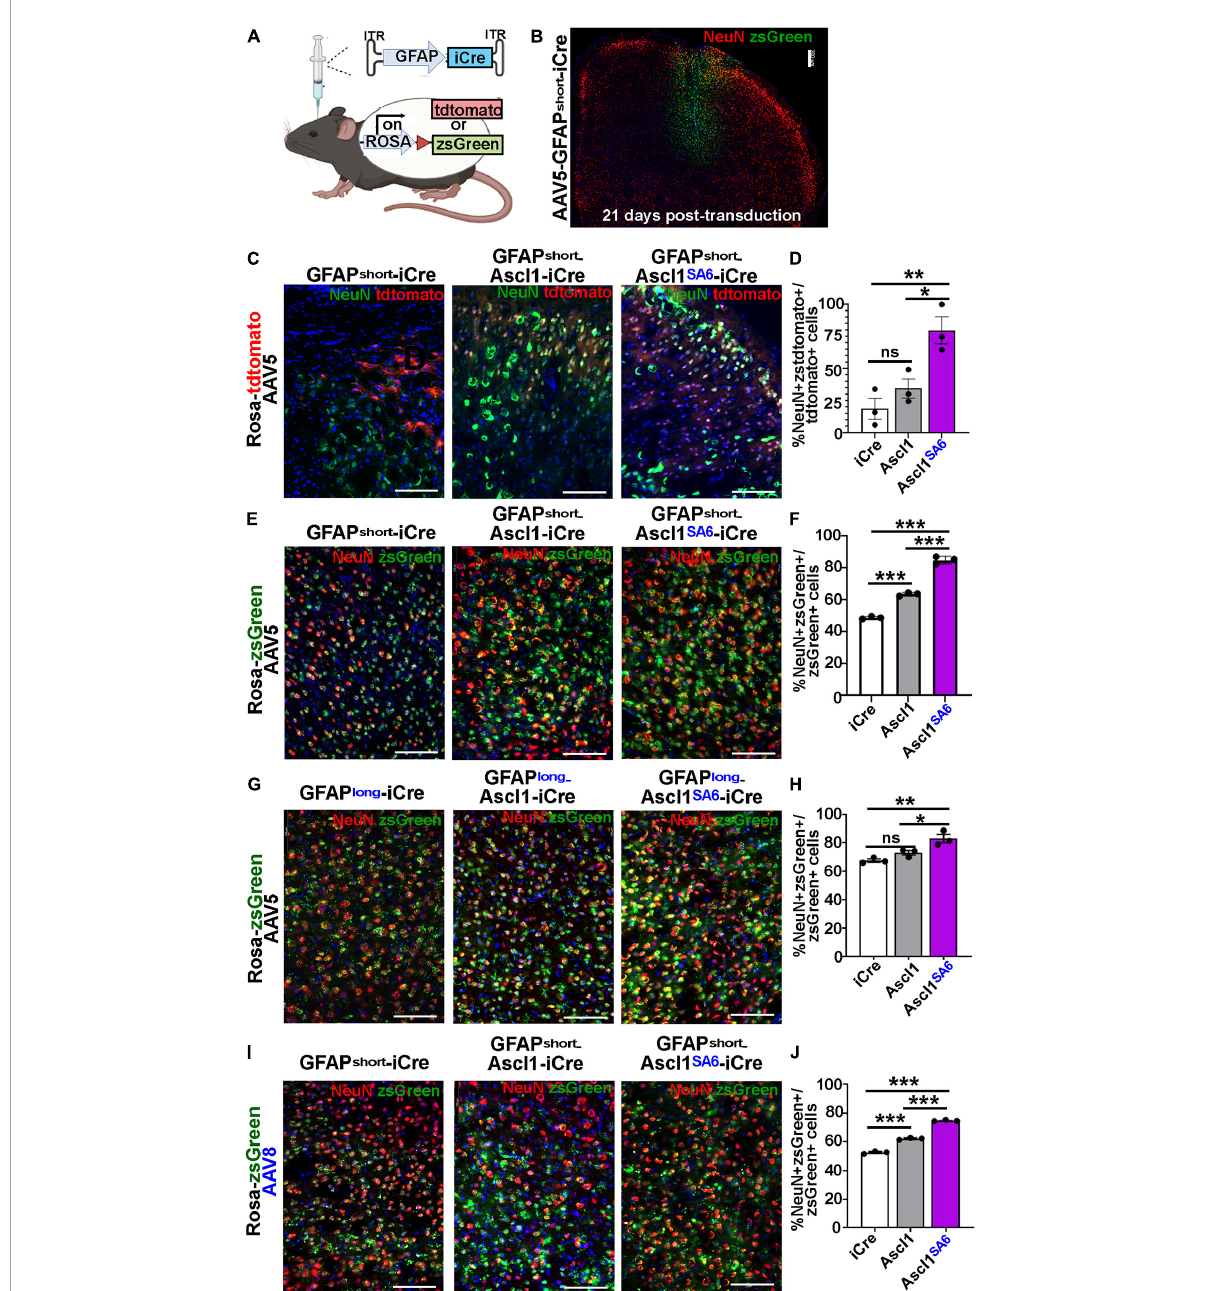
FIGURE4 Ascl1 SA 6 induces more transduced cortical cells to express NeuN, a mature neuronal marker, than Ascl1. (A) Schematic illustration of Cre-based lineage tracing strategy, using AAV5-GFAPshort vectors and Rosa-tdtomato or Rosa-zsGreen transgenic animals. (B) Low magnification image of Rosa-zsGreen cortex transduced with AAV5-GFAPshort-iCre at 21 days post-transduction, showing zsGreen epifluorescence and NeuN expression. (C) Rosa-tdtomato cortex transduced with AAV5-GFAPshort-iCre, AAV5-GFAPshort-Ascl1-t2a-iCre, and AAV5-GFAPshort-Ascl1 SA 6 -t2a-iCre at 21 days post-transduction, showing tdtomato epifluorescence and NeuN expression. (D) Quantification of the percentage of tdtomato + cells that co-express NeuN. (E) Rosa-zsGreen cortex transduced with AAV5-GFAPshort-iCre, AAV5-GFAPshort-Ascl1-t2a-iCre, and AAV5-GFAPshort-Ascl1 SA 6 -t2a-iCre at 21 days post-transduction, showing zsGreen epifluorescence and NeuN expression. (F) Quantification of the percentage of zsGreen + cells that co-express NeuN. (G) Rosa-zsGreen cortex transduced with AAV5-GFAPlong-iCre, AAV5-GFAPlong-Ascl1-t2a-iCre, and AAV5-GFAPlong-Ascl1 SA 6 -t2a-iCre at 21 days post-transduction, showing zsGreen epifluorescence and NeuN expression. (H) Quantification of the percentage of zsGreen + cells that co-express NeuN. (I) Rosa-zsGreen cortex transduced with AAV8-GFAPshort-iCre, AAV8-GFAPshort-Ascl1-t2a-iCre, and AAV8-GFAPshort-Ascl1 SA 6 -t2a-iCre at 21 days post-transduction, showing zsGreen epifluorescence and NeuN expression. (J) Quantification of the percentage of zsGreen + cells that co-express NeuN. Scale bars in panel B = 200 µ m, and panels C,E,G,I = 100 µ m. Significance was defined as p -values less than 0.05 and denoted as follows: ns, not significant, < 0.05 *, < 0.01 **, < 0.001